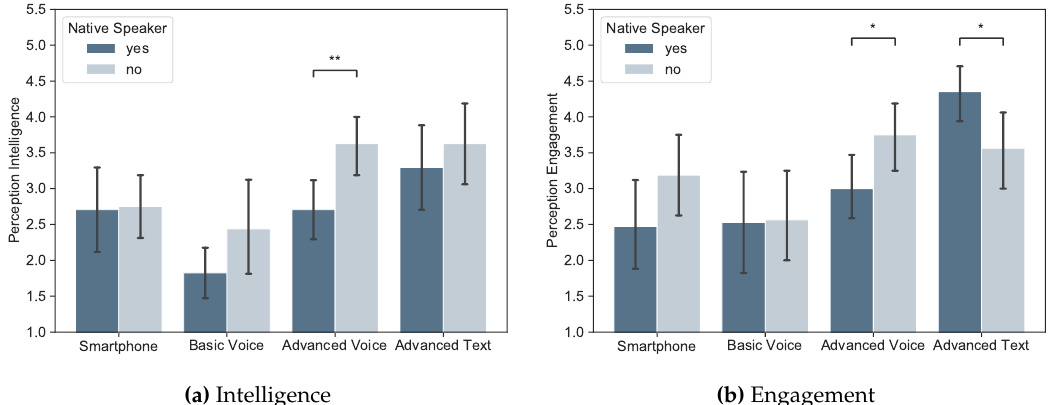
Figure 6. Perceived levels of Intelligence and Engagement per agent for native and non-native speaker. Error bars represent the 95% confidence interval. Note: * p < 0.05, ** p < 0.01, *** p <